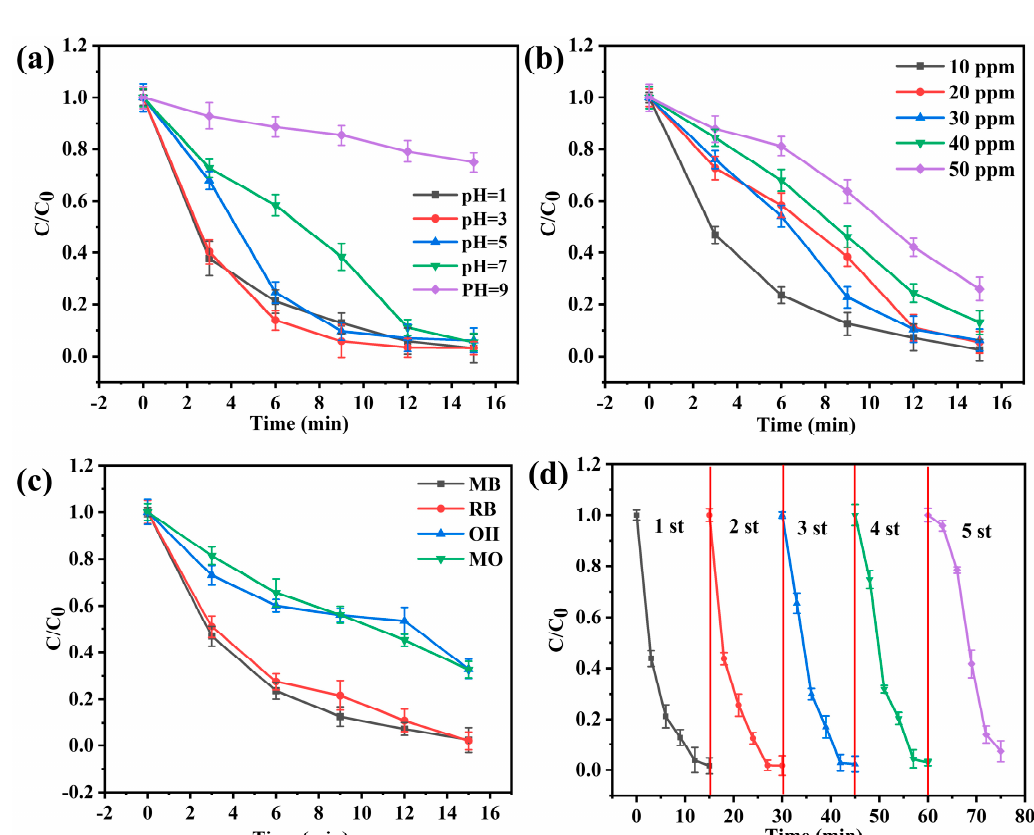
Figure 7. Influence of experimental conditions on degradation performance (FeC 2 O 4 content = 80%, pH 0 = 7, (MB) = 10 ppm, (H 2 O 2 ) = 100 ppm, T = 20 °C): ( a ) initial pH; ( b ) MB concentration; ( c ) various dyes; ( d ) five periods of ANFs/FeC 2 O 4 recycling.